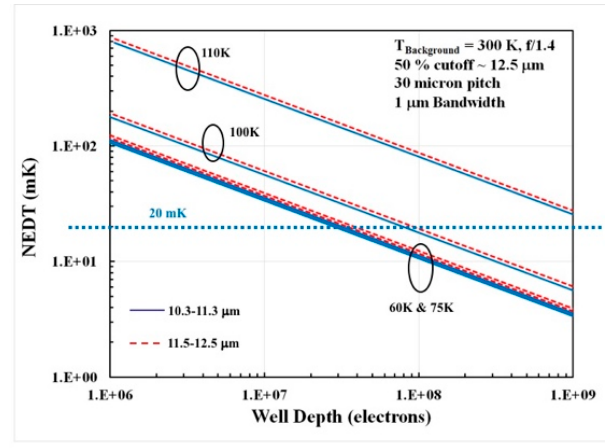
Figure 3. NE Δ T vs. ROIC well depth as a function of LWIR BIRD FPA operating temperature for two Landsat wavelength bands (from 10.3–11.3 μ m and 11.5–12.5 μ m) with 250 K background and f/1.4 aperture